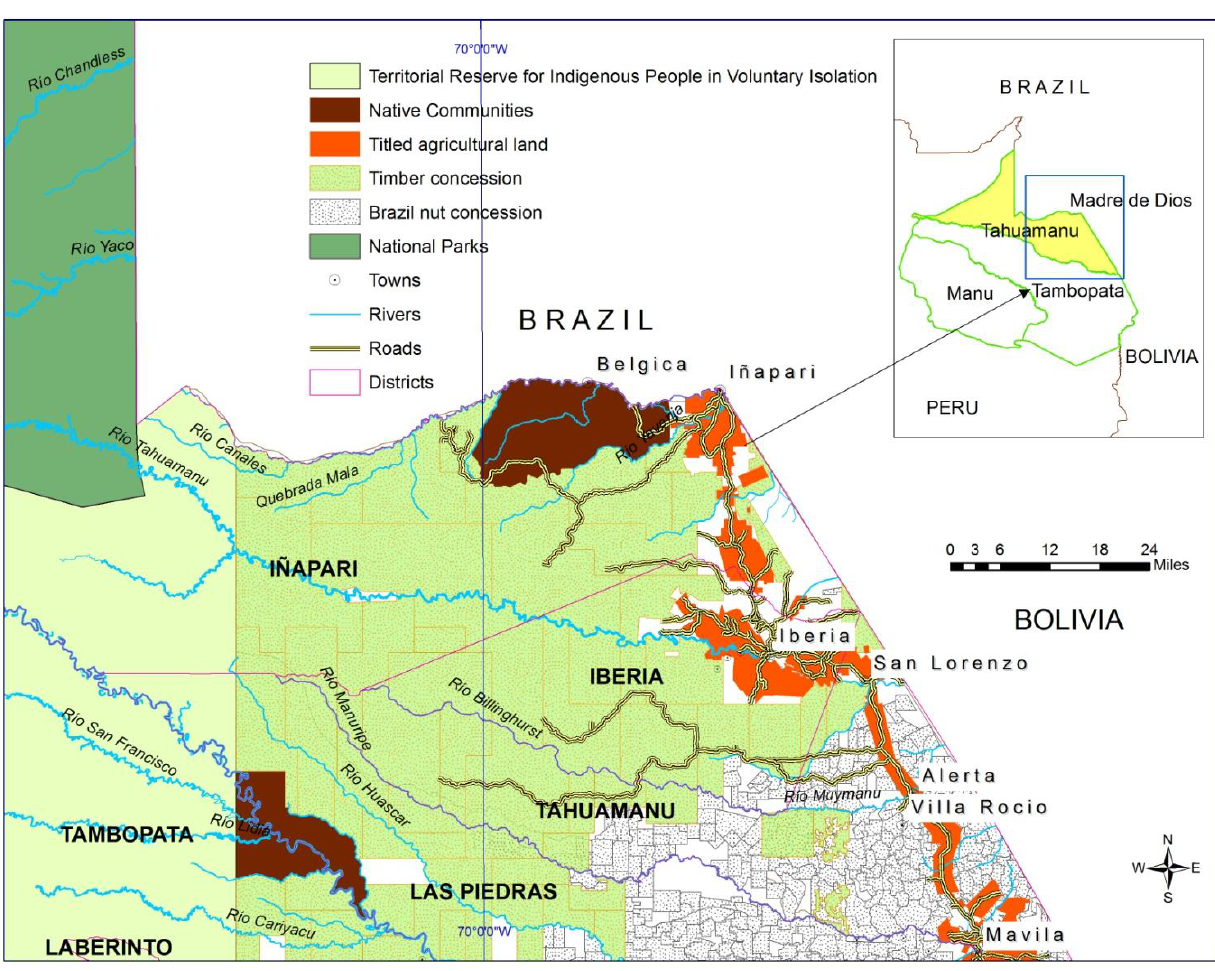
Figure 2. Land Tenure Distribution in the Provinces of Tahuamanu and adjacent areas in Madre de Dios (Source: Instituto Nacional de Recursos Forestales (INRENA) and Proyecto Especial de Titulación de Tierras